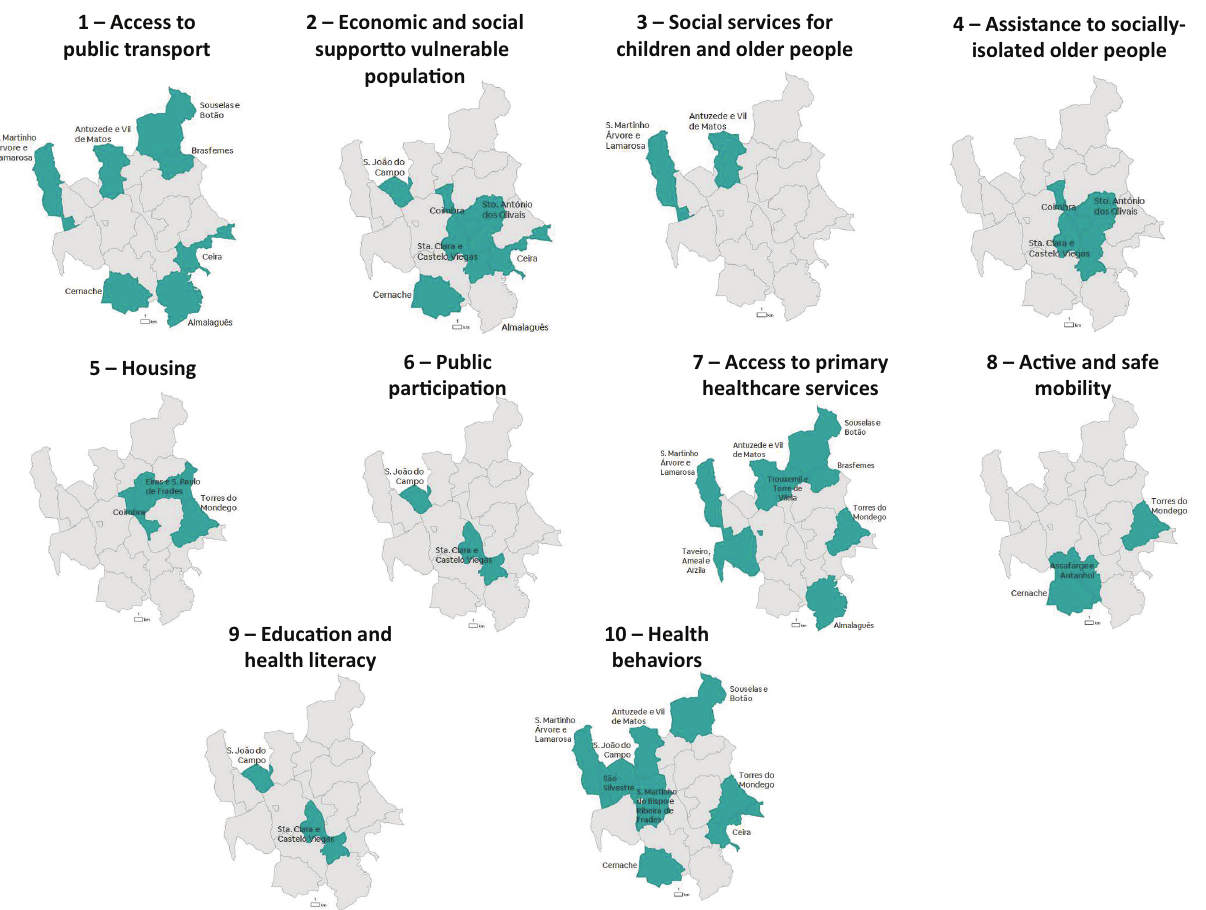
Figure 8. Geographical incidence of the 10 priorities of intervention. Source: Câmara Municipal de Coimbra and University of Coimbra